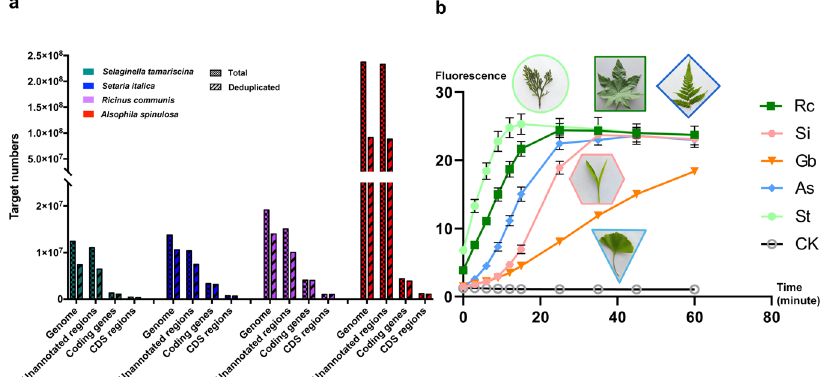
Fig. 5 Application of GAGE in plants from different classes. a Statistics of Targets in different classi fi cation derived from the four genomes. Genome: Targets located in the whole genome; Unannotated regions: Targets located in the unannotated regions of genome; Coding genes: Targets located in coding genes; CDS: Targets located in CDS. b Result of employing GAGE in plants from different classes. The DNA substrates and crRNA of every group were as follow: Rc: ITS2 fragments of R. communis + Rc_crRNA; Si: ITS2 fragments of Set. italica + Si_crRNA; Gb: ITS2 fragments of G. biloba +